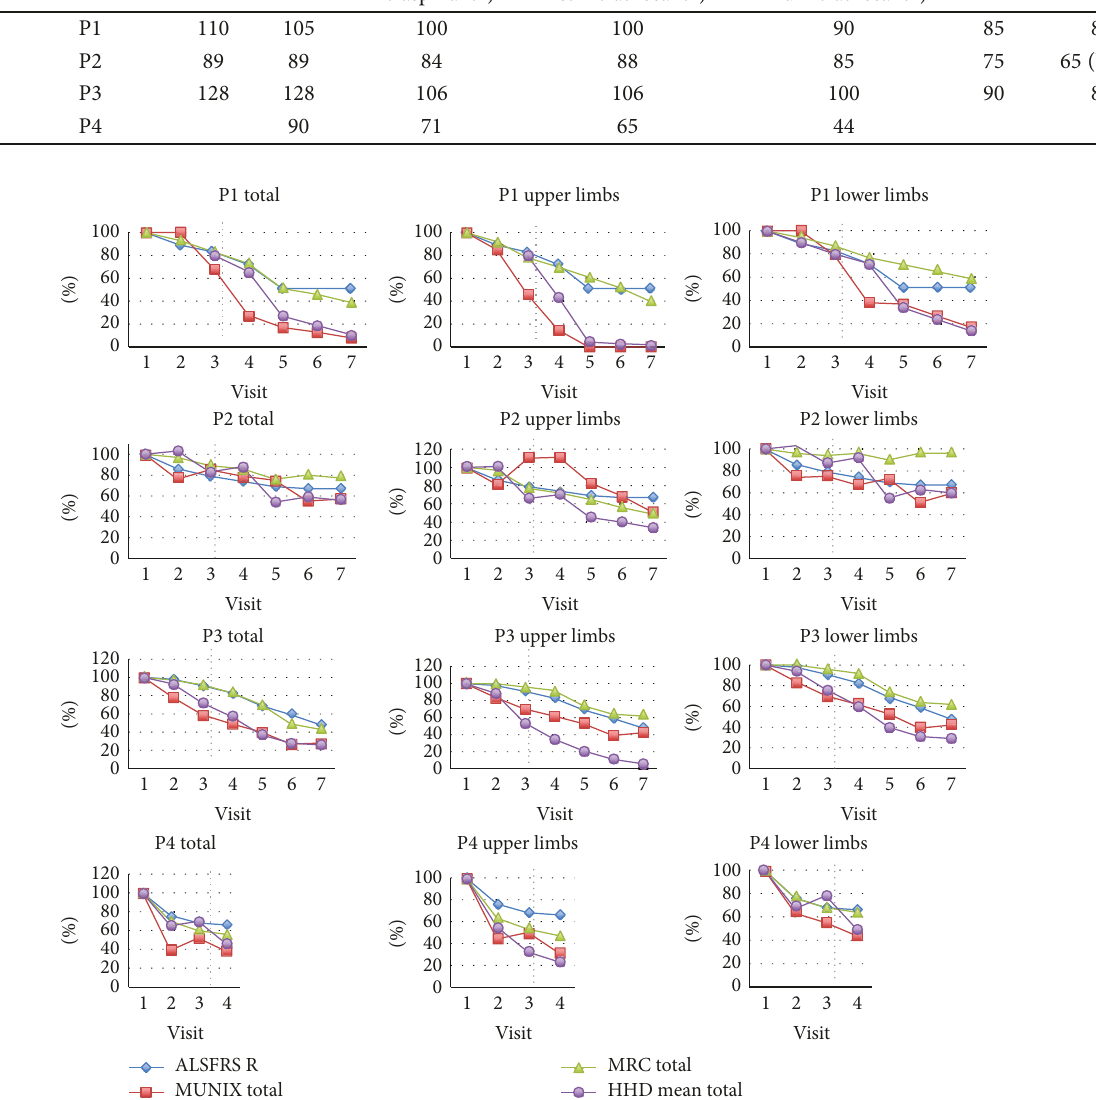
Table 4: Longitudinal forced vital capacity assessment in ALS patients prior to and after ADRC administration. Patient/visit V1